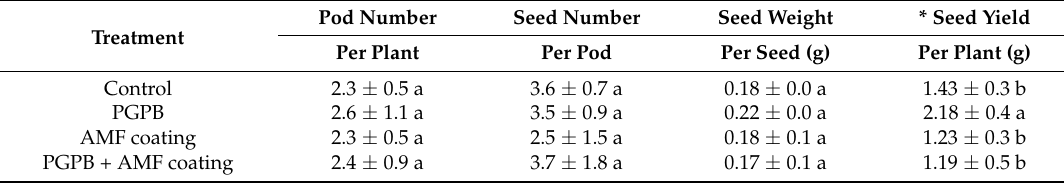
Table 3. Number of pods and seeds, seed weight and seed yield of